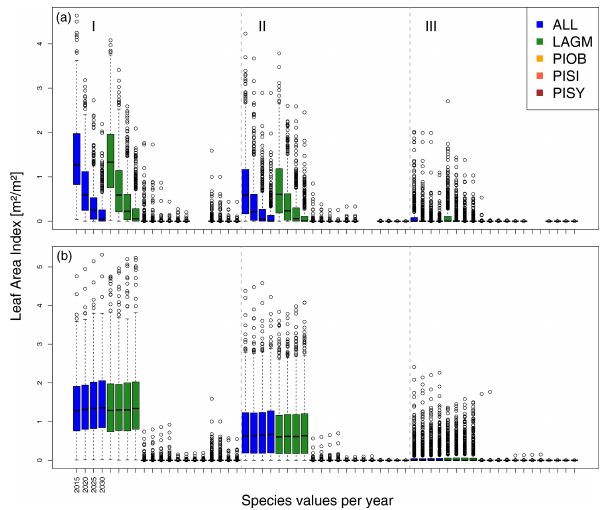
Figure 7. Leaf area index (LAI) values at Spasskaya Pad for three areas within the simulation areas (I, II, III) on the same plot at which CryoGrid was called (upper row) and only LAVESI runs (lower row). LAGM: Larix gmelinii ; PIOB: Picea obovata ; PISI: Pinus sibirica ; PISY: Pinus sylvestris